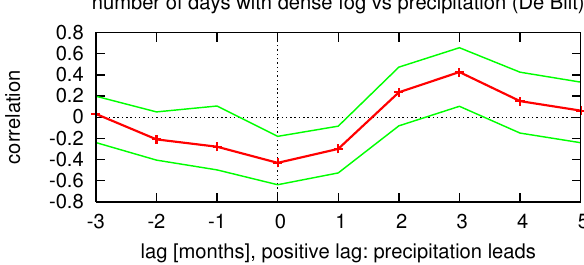
Fig. 11. Lag correlations of the number of days with minimum visibility less than 200m at De Bilt in July–August with 2-month summed precipitation at the same station. Both series have been high-pass filtered by taking year-on-year differences. The green line indicates the 95% confidence interval, computed with a bootstrap method.